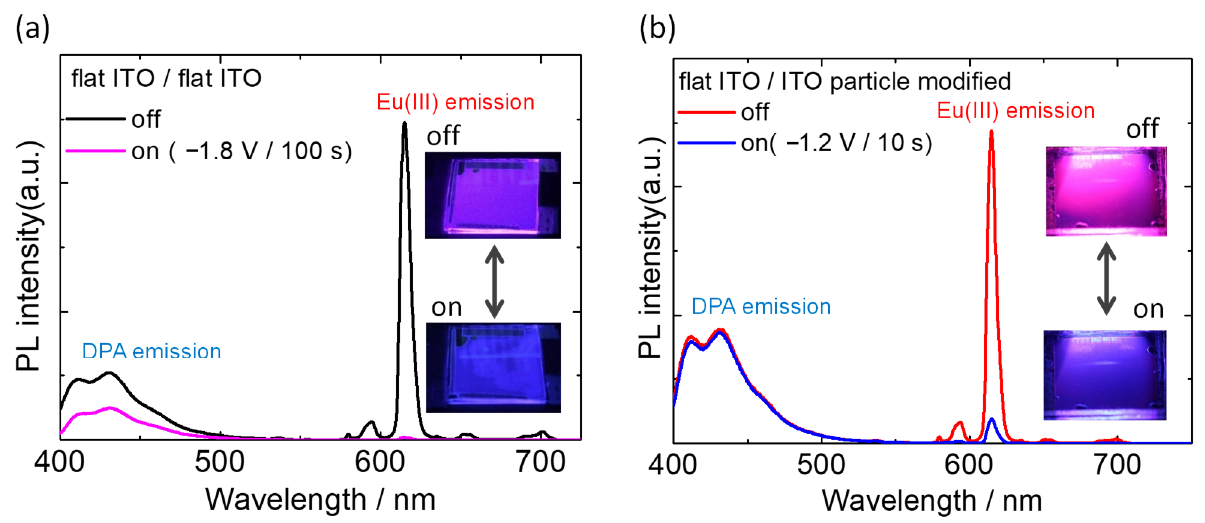
Figure 6. PL spectra of the electrofluorochromic devices containing Eu(hfa) 3 (TPPO) 2 /DPA/HV 2+ solution with or without application of reduction voltage. ( a ) The device consists of two flat ITO electrodes, and ( b ) flat ITO electrode and ITO particle-modified electrode. The luminescent molecules in the electrolyte solution were photo excited by 333 nm light.